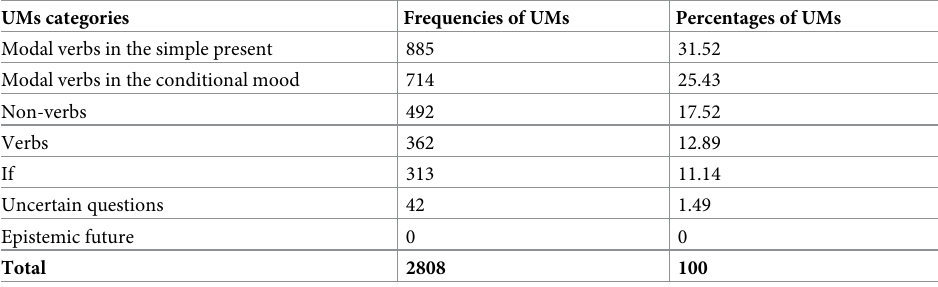
Table 2. Frequencies and percentages of UMs in BMJ 1840–2007 articles.